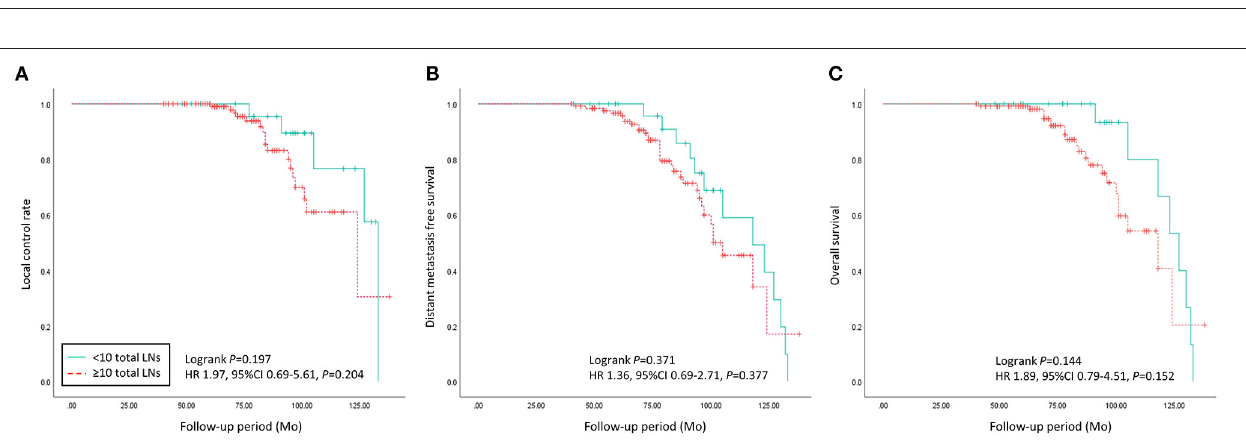
Frontiers in Surgery |